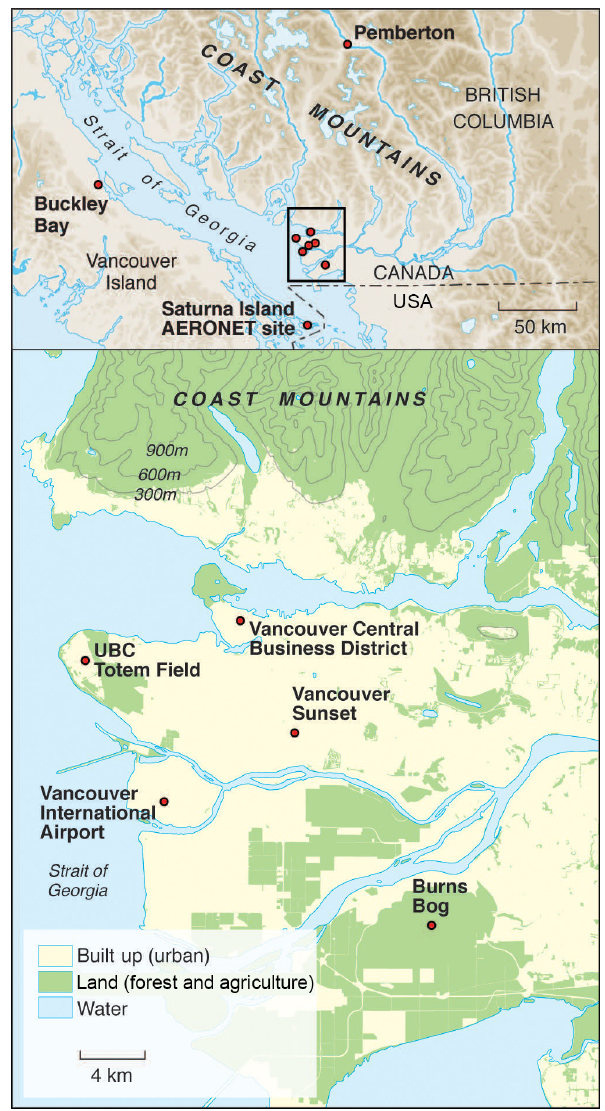
Figure 1. Map with inset showing all places mentioned in text.